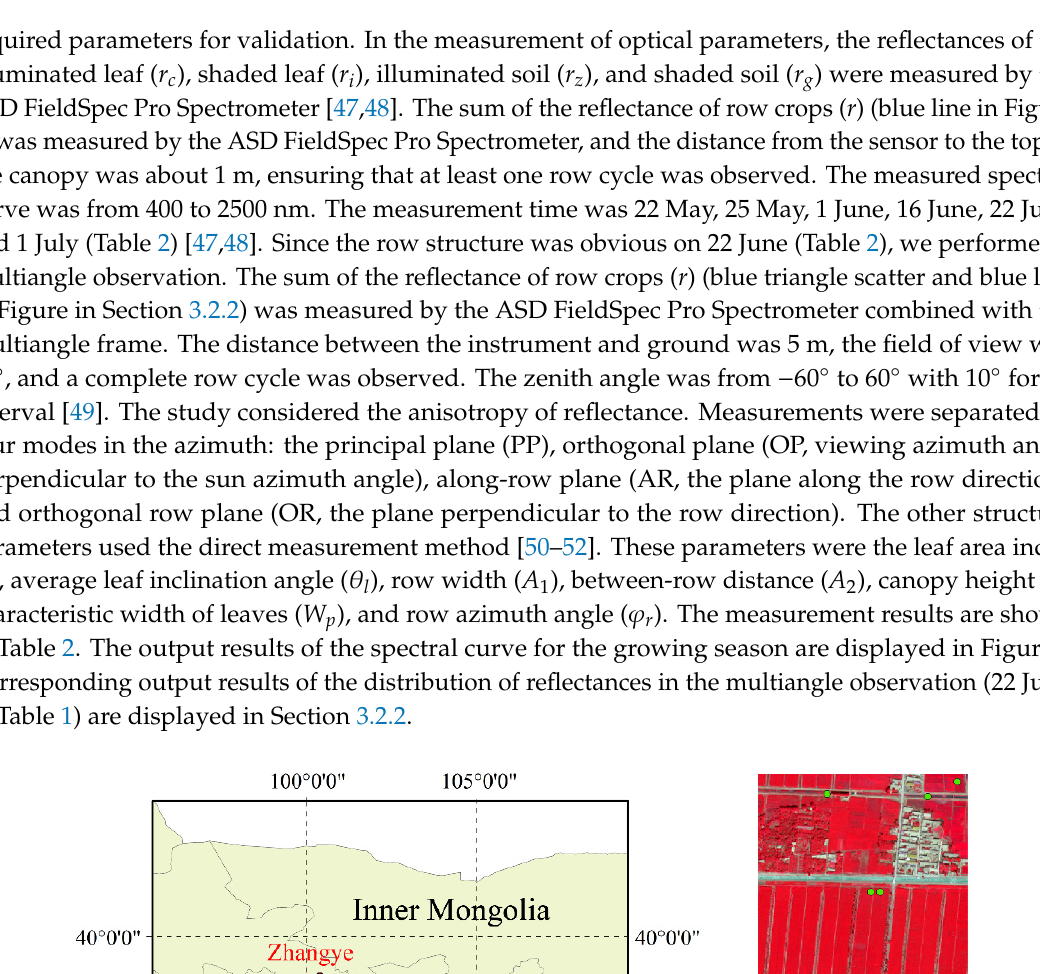
Table 2. Structural parameters of corn in the growing season.